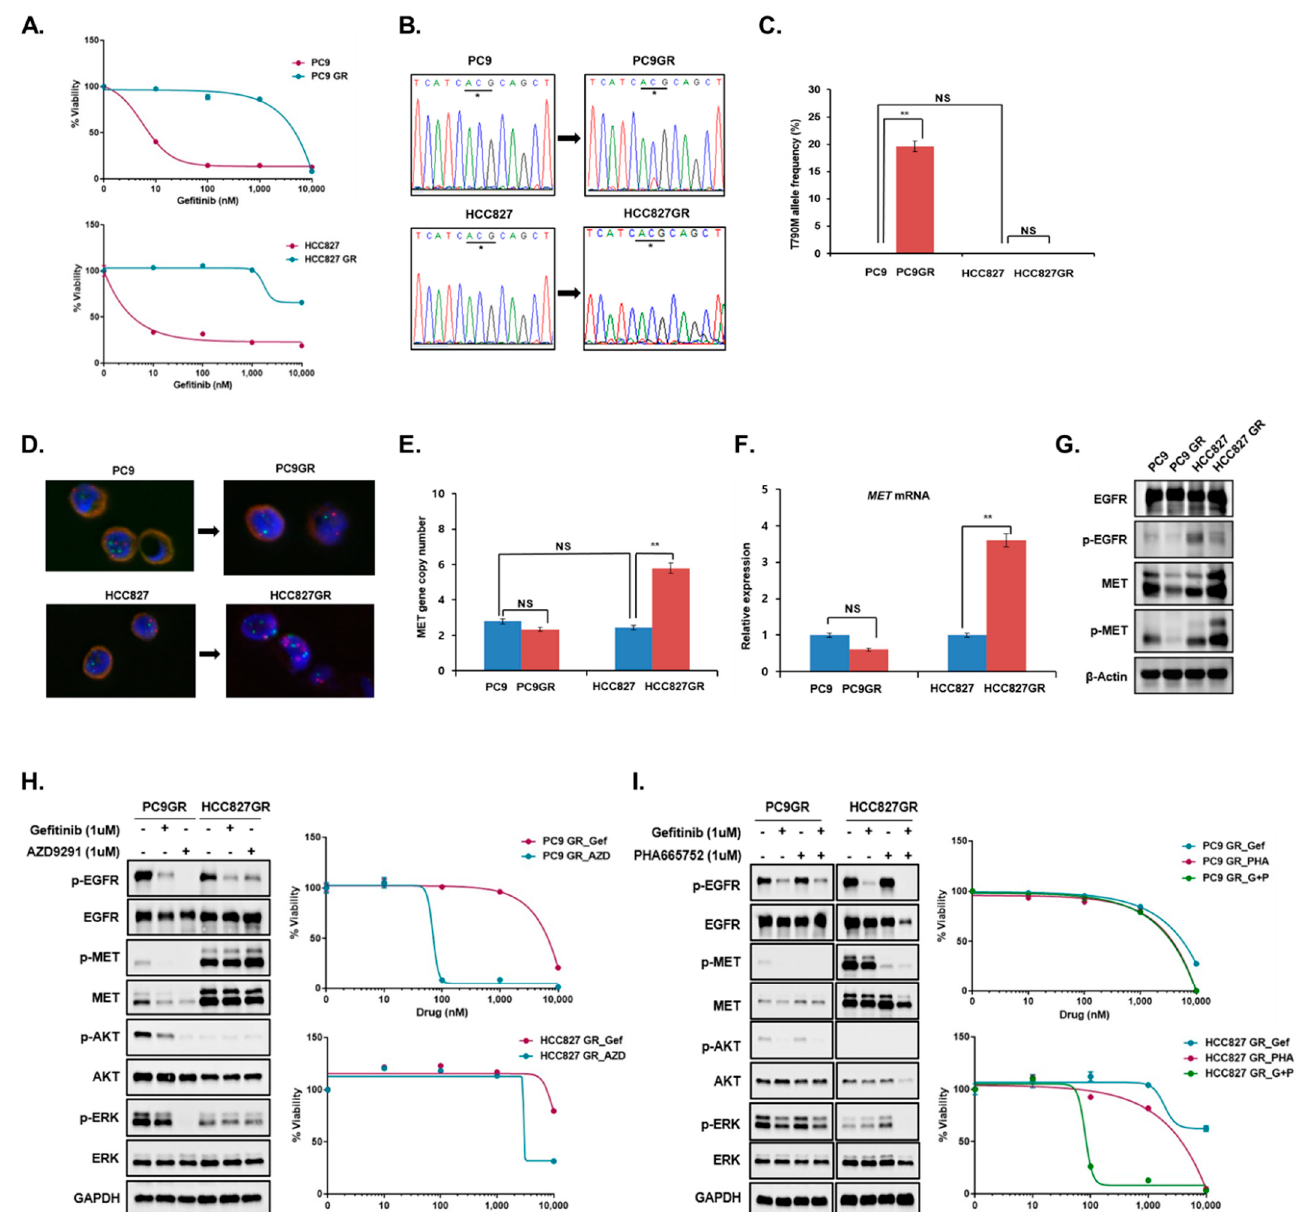
Figure 1. PC9GR and HCC827GR were established, and acquired resistance mechanisms were evaluated. ( A ) Cell viability assays were performed to compare the drug sensitivity of parent cells and EGFR-TKI-resistant cells. ( B ) Direct sequencing and ( C ) ddPCR assays were performed to evaluate the presence of secondary EGFR T790M resistance mutations. ( D ) Fluorescence in situ hybridization assays (green signal: centromere 17; red signal: C-MET gene) and ( E ) ddPCR assays were performed to evaluate C-MET amplification. ( F , G ) C-MET mRNA expression was measured by RT-PCR, and C-MET protein expression was evaluated by Western blotting. ( H , I ) Drug sensitivity to AZD9291 (a selective EGFR inhibitor specific to T790M mutation) and PHA665752 (a selective MET inhibitor) was tested in PC9GR and HCC827GR cells, and then C-MET, EGFR, and EGFR downstream (AKT, ERK) protein expression was evaluated by Western blotting. In all graphs, the error bars represent the mean ± SEM. Statistical analysis was performed using two-sample t -test. * p ≤ 0.5, ** p ≤ 0.05; NS, not significant.